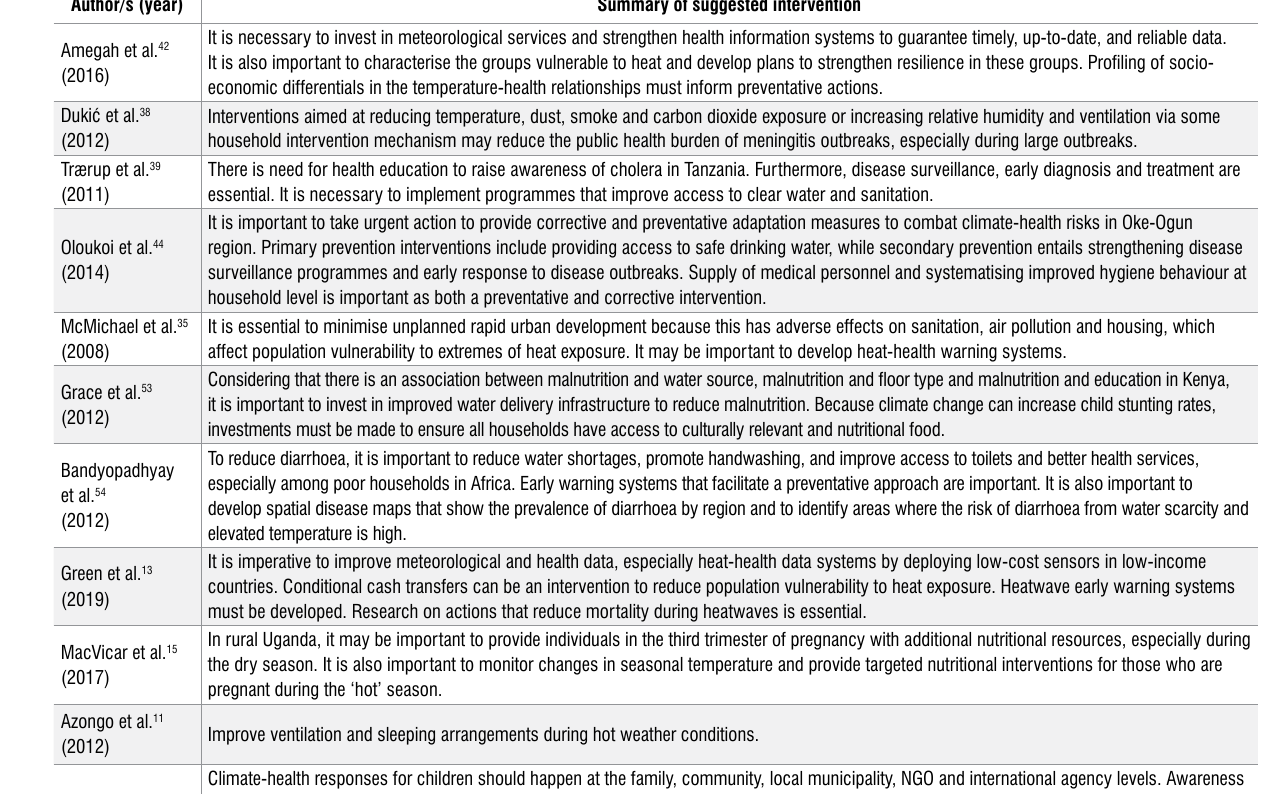
Summary of suggested